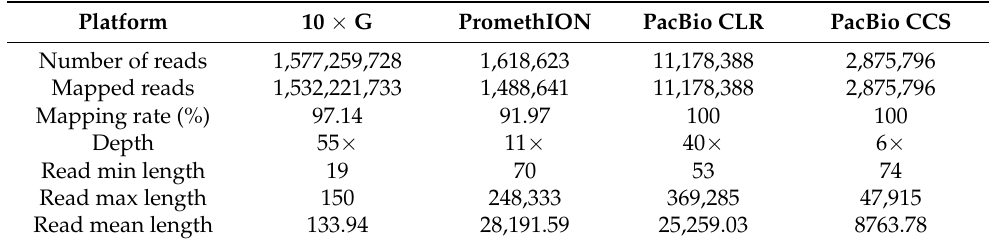
Table 1. Yield and alignment coverage statistics for the cattle lung sample across various sequenc- ing platforms.